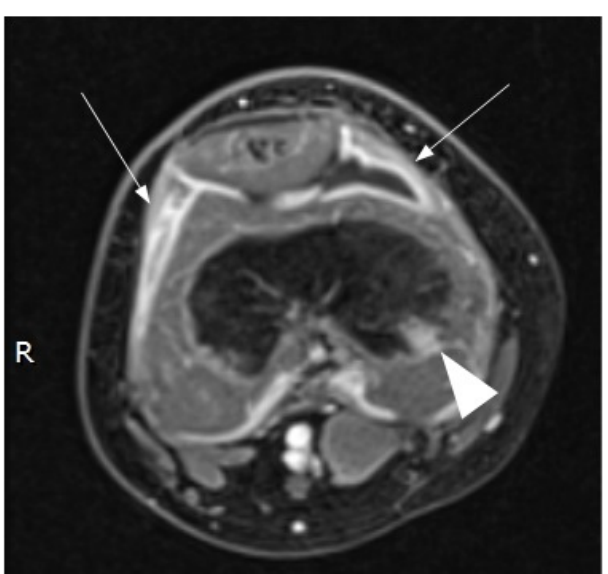
Figure 2. Magnetic resonance imaging (MRI) of the right knee (contrast-enhanced, axial, T1 fat-suppressed image) confirmed the presence of fluid in the suprapatellar bursa surrounded by a thickened synovial line with homogeneous contrast enhancement (arrows). Moreover, MRI detected a small bone flogistic localization in the distal epiphysis of the right femur.